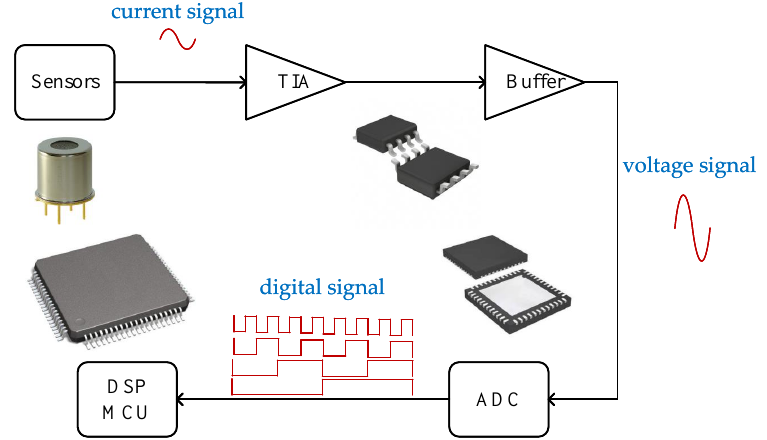
Figure 1. The architecture of the weak current signal detection